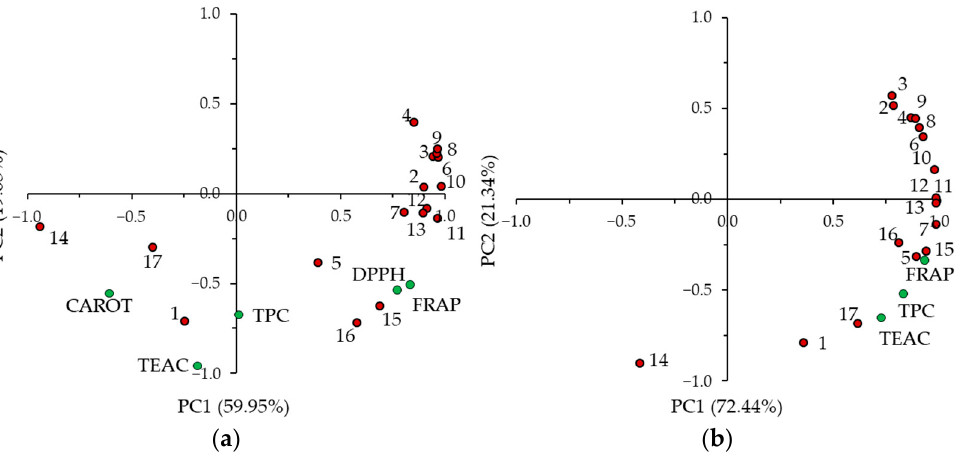
Figure 2. Principal component analysis (PCA) plots with distribution of the variables of the flax extracts ( a ) and of the fresh matter of flax ( b ); 1–17, contents of the individual phenolic compounds (see Table 2); CAROT, inhibition of β -carotene-linoleic acid emulsion oxidation; DPPH, DPPH • scavenging activity; FRAP, ferric-reducing antioxidant power; TEAC, Trolox equivalent antioxi- dant capacity; TPC, total phenolic content.